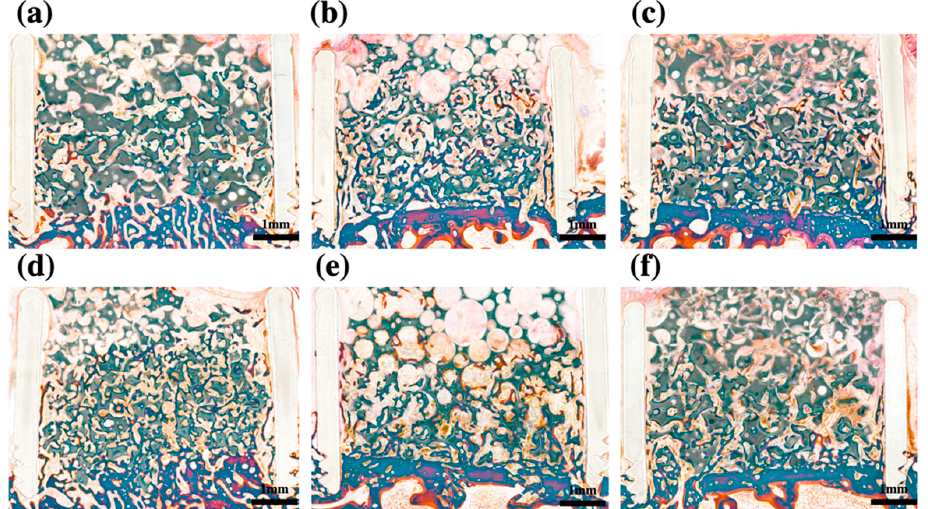
Figure 3. Histomorphometric analysis after 3 weeks. ( a ) BCP powder containing 0.1 mg/mL